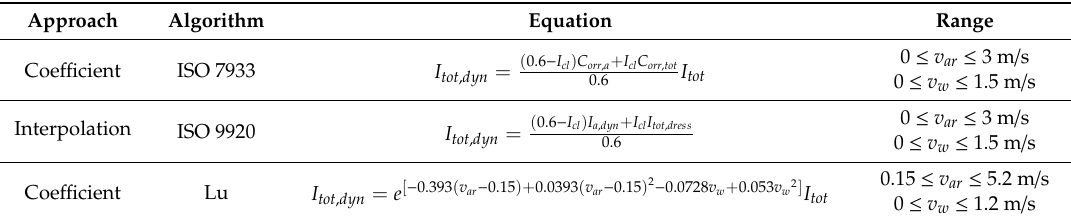
Table 3. Comparison of di ff erent approaches and di ff erent equations of light clothing (LC) according to ISO 7933, ISO 9920, and the study of